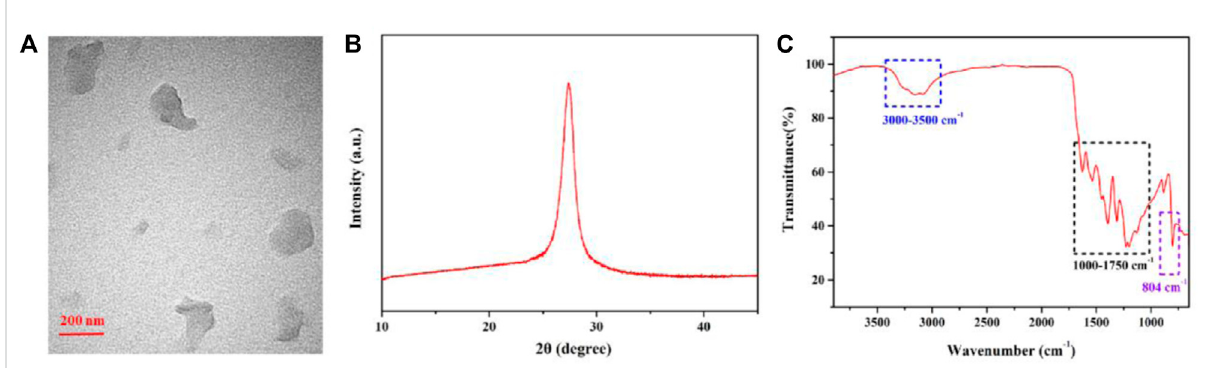
FIGURE 1 The Characterization of CN NNS (A) TEM image; (B) XRD image; (C) FT-IR spectrum.